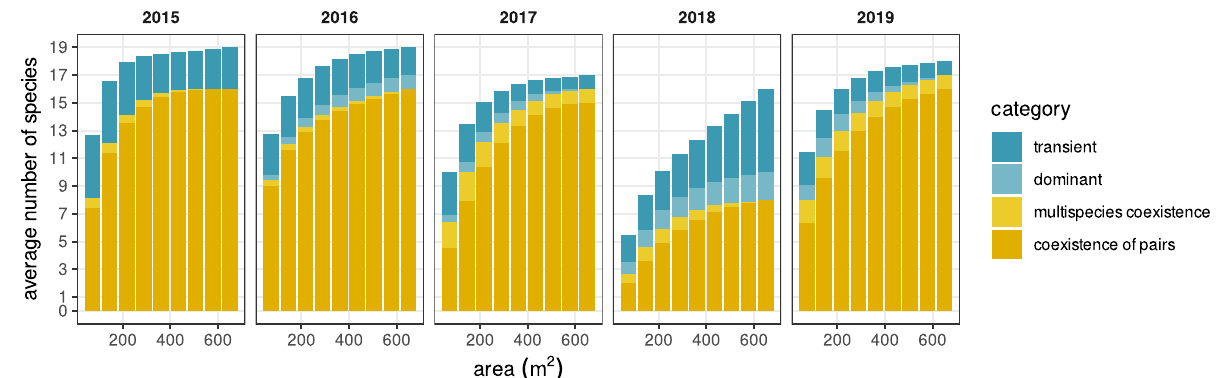
Fig. 3 Coexistence relationships and their variability with spatial extent. Relative bar height for each color represents the average number of species in each category when pooled across combinations of plots. These categories detail which speci fi c con fi guration of species interactions predict their persistence. Con fi gurations of direct interactions that promote persistence of species pairs (category coexistence of species pairs, dark yellow bars) show across years an overwhelming importance for shaping species – area relationships. Note also that species predicted to be transient (i.e., species not predicted to persist, dark blue bars) are a general feature of the system, and their relative proportion increased during the year of the extreme fl ooding event (2018). A fully detailed explanation for each category describing how species persist under different con fi guration of species interactions is given in “ Methods ” , under section “ Analyzing species persistence ” .